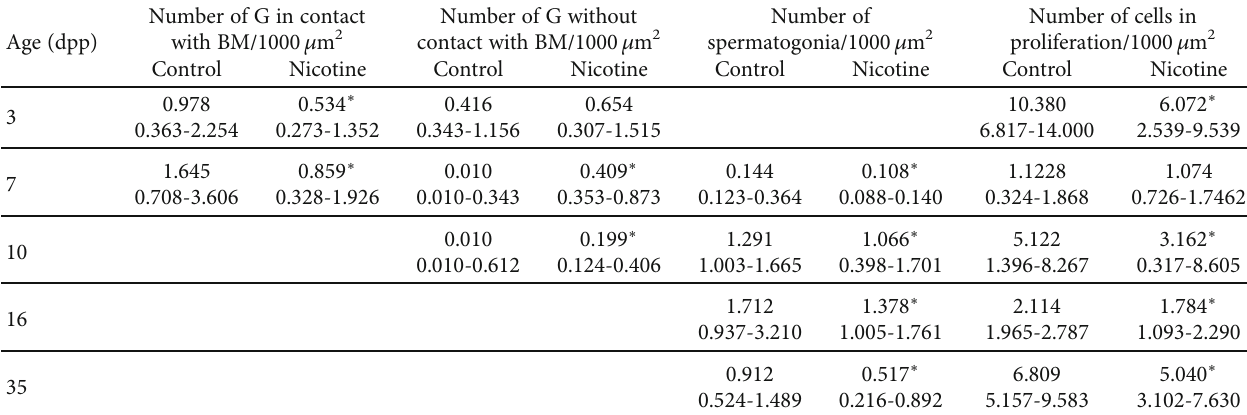
Table 2: Evaluated parameters (median and interquartile ranges) in control and nicotine-exposed